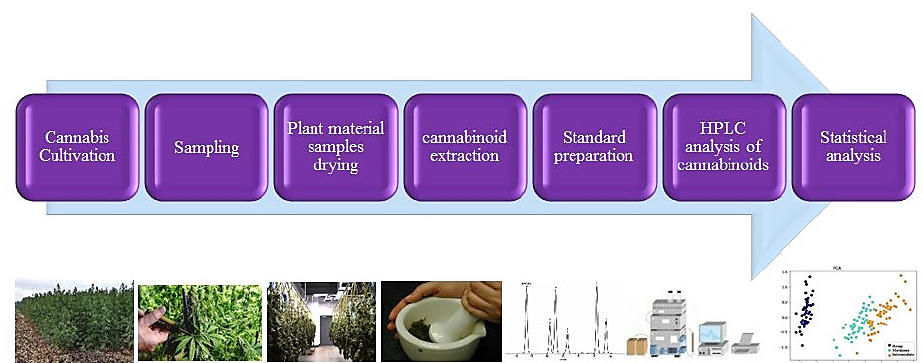
Figure 6. A workflow of cannabinoids assay and quantification.